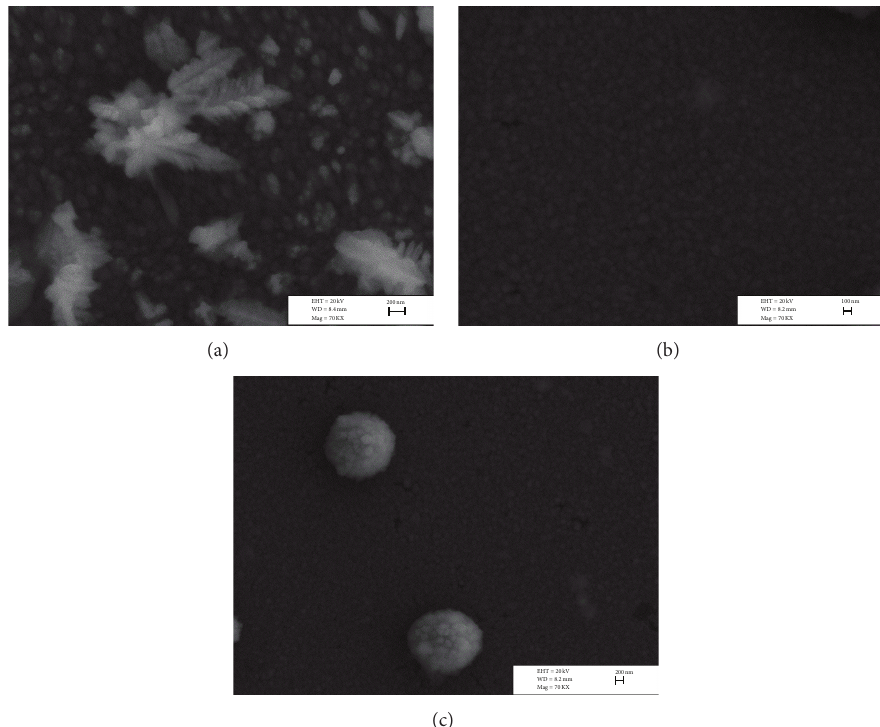
Figure 3: SEM topographic images of Fe–Cu films electrodeposited from the electrolytes with low and high Fe ion concentrations (a) 0.02 M, (b) 0.08M, and (c) 0.08 M at lower magnification,